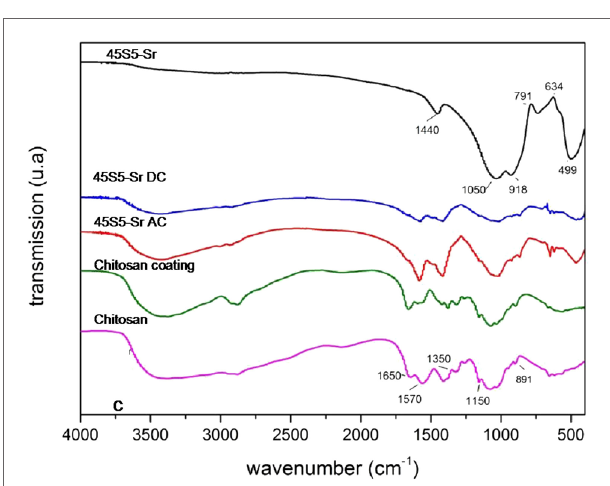
FigUre 9 | FTir spectra of chitosan/45s5-sr . The relevant peaks are explained in the